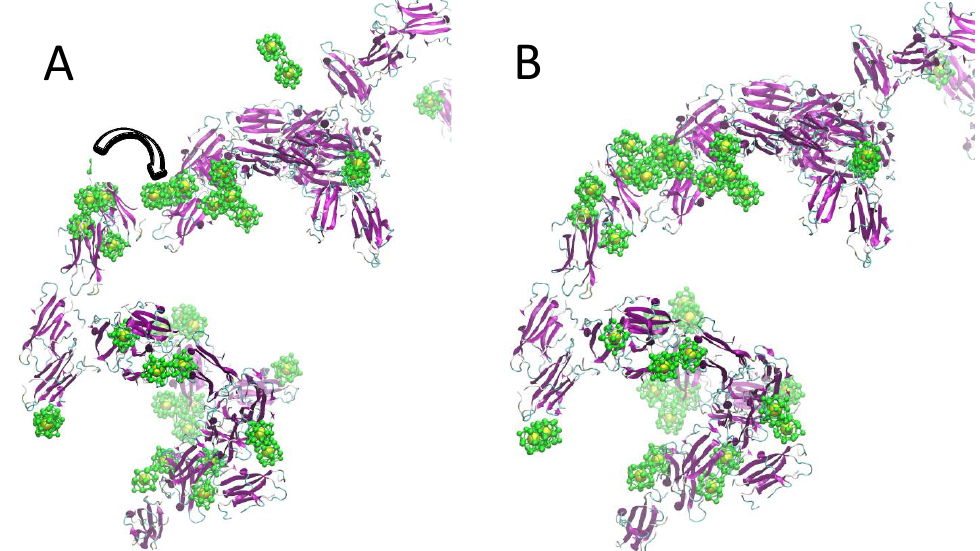
Figure 3. Formation of larger protein-NP aggregates during multiple solute simulations. ( A ) Formation of protein-NP oligomers with the NPs intercalating between protein-protein complexes especially by contacting the protein through the apical regions ( B ) The separated protein-NP complexes are associating into larger aggregates through the NP-NP interaction occurring via protein apical region already covered with NPs. Protein all-atom reconstruction was performed with PULCHRA [26,27]. The formation of larger complexes is stabilized mainly by non-polar hydrophobic protein-NP interactions and protein-protein electrostatic interactions, but at longer timescale is mediated by the NP-NP interactions (see Figure